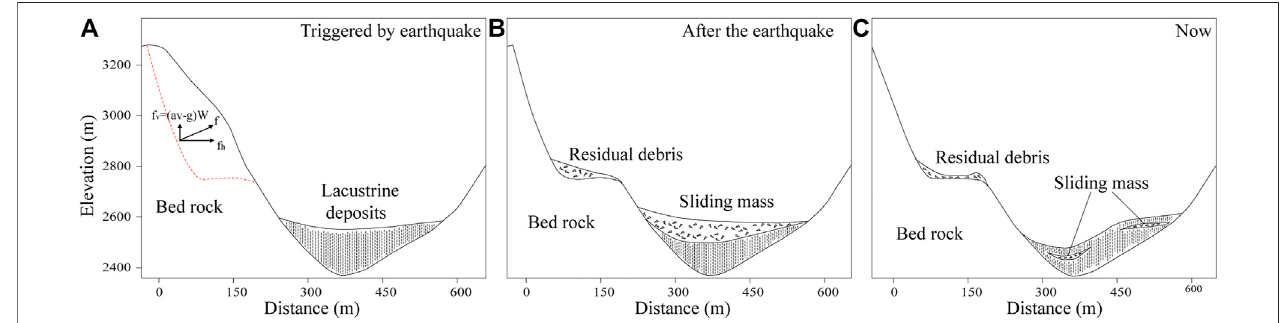
FIGURE8|(A) Whenanearthquakeoccurs,thesurroundingmountainsareaffectedbyseismicwaves,androcksbreakandfallintothelake. (B) Afterthelandslide occurs, the majority of the sliding rock mass accumulates in the lake, and a small amount of the debris remains on the platform. (C) After a long period of evolution, the landslide sediments are buried by lacustrine